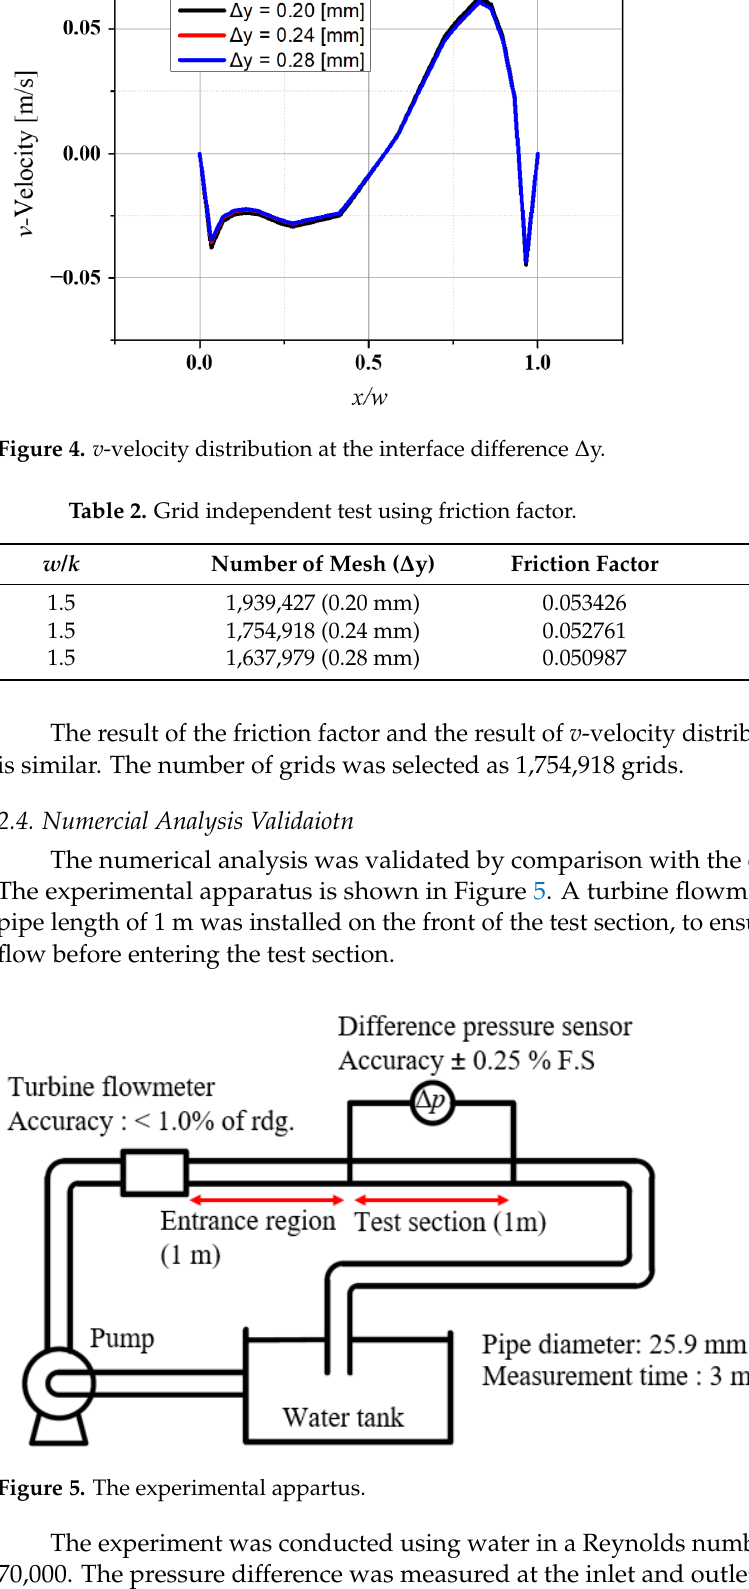
Figure 6. Comparing the velocity profile at the center of the groove . Table 3. Comparison of Experimental results and Numerical results based on friction factor. Re